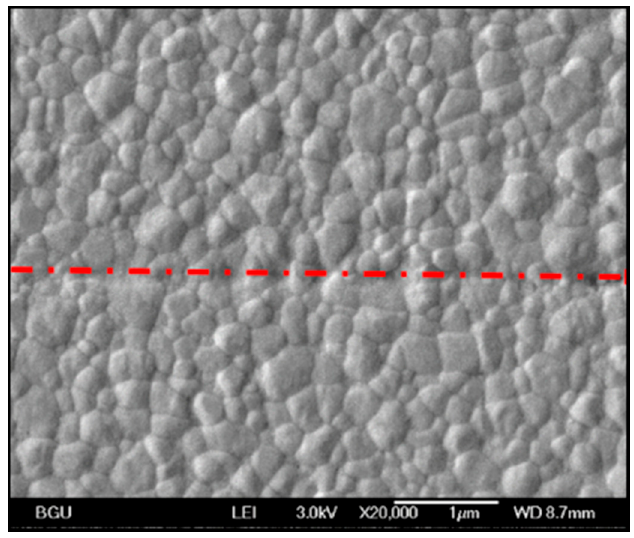
Figure 2. HR-SEM image of a (3Y)-TZP/(3Y)-TZP bonding area cross-section.